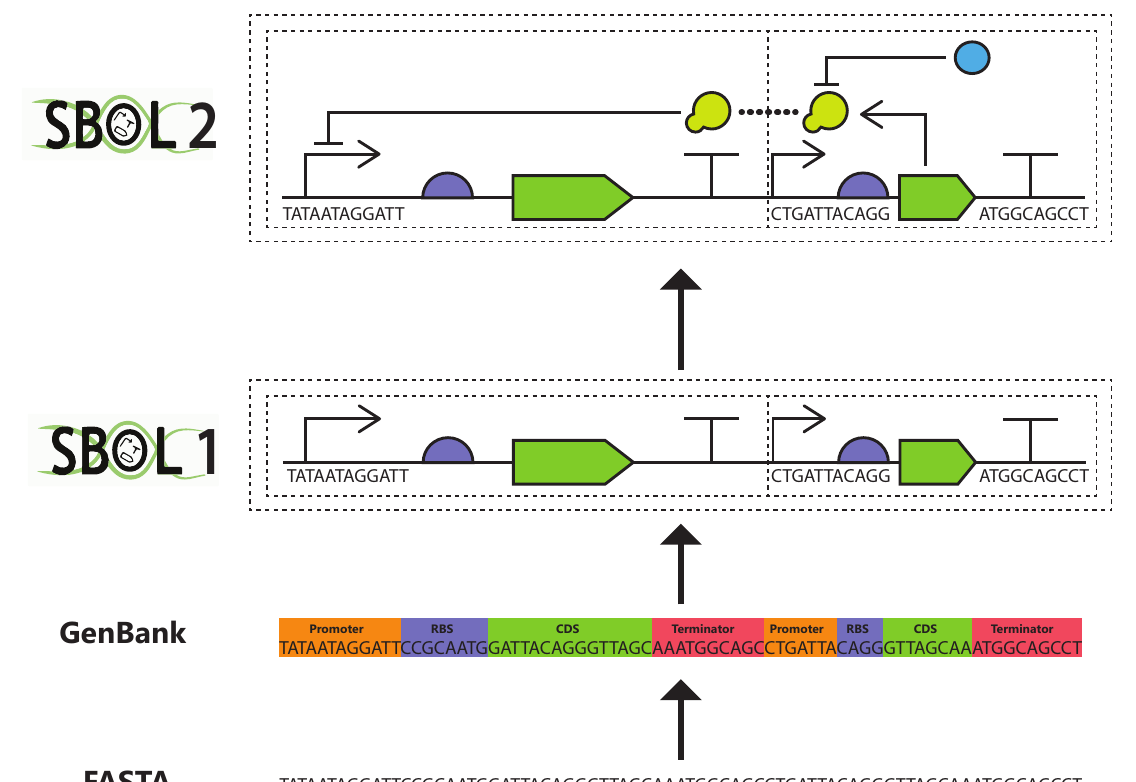
Figure 1: SBOL 2 extends prior sequence description formats to represent both the structure and function of a genetic design in a modular, hierarchical